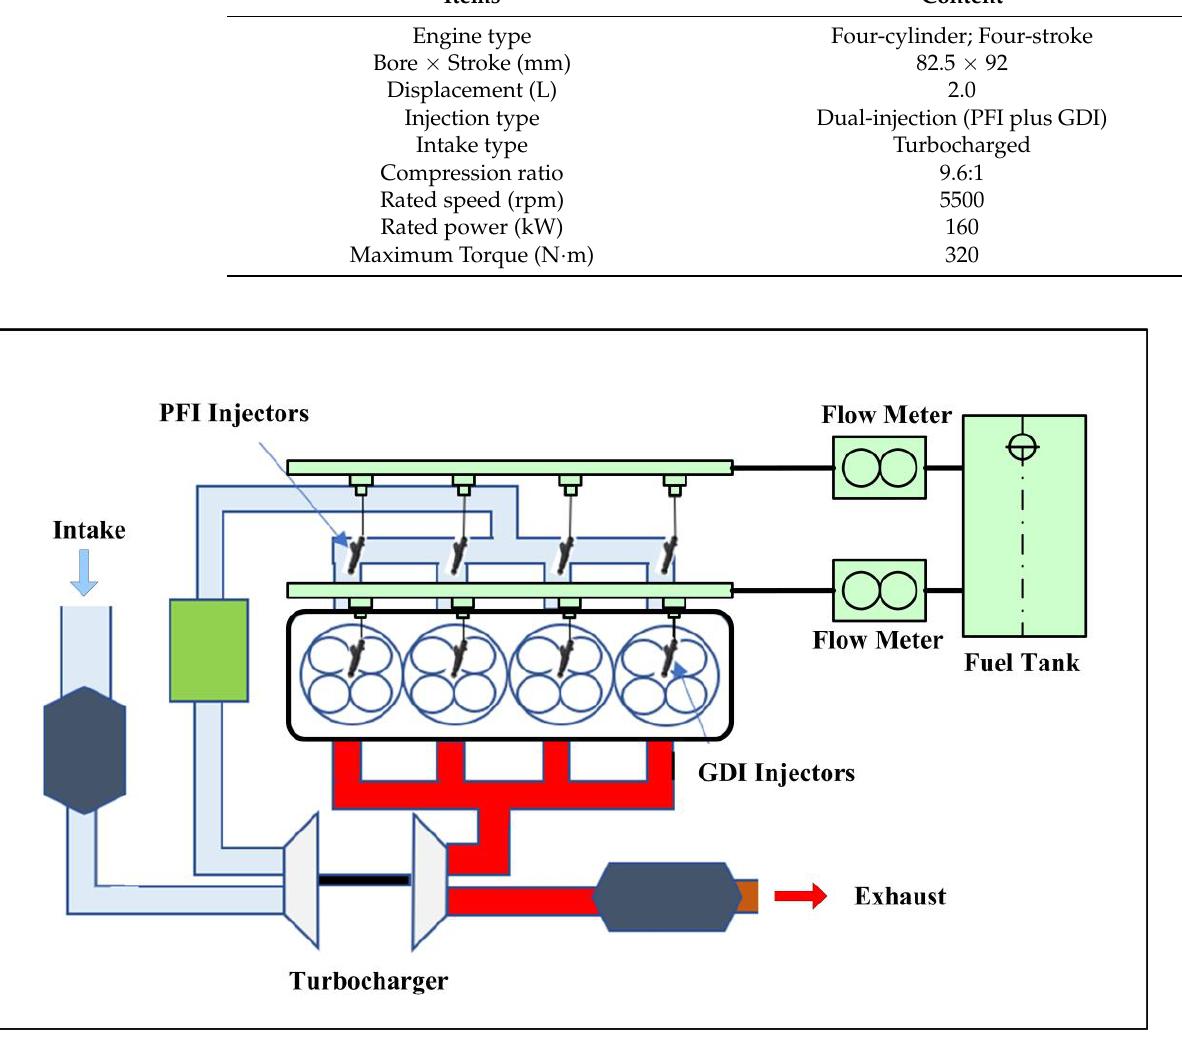
Figure 4. Schematic of engine testbed.